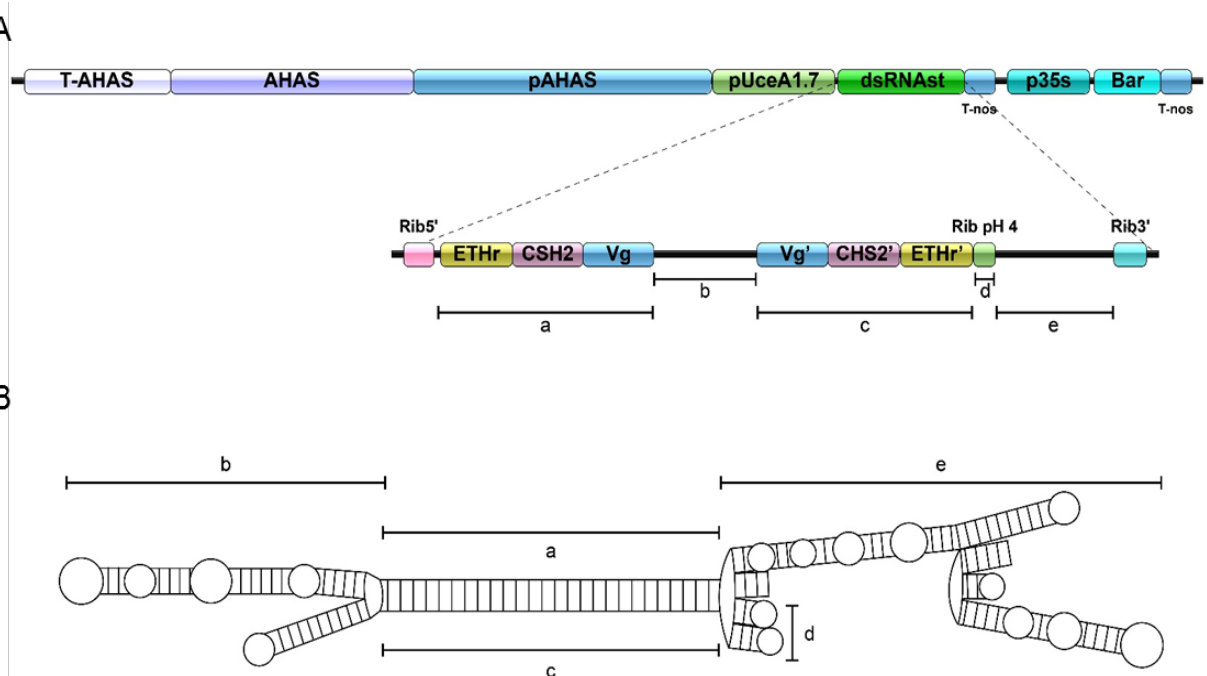
Figure 2. Map of the vector used for cotton transformation. ( A ) Schematic representation of the T-DNA construct for structured dsRNA (dsRNAst) expression in transgenic cotton. The binary vector pCambia3300 was used as the backbone. Imazapyr resistance is conferred to transformed plant cells by the Arabidopsis ahas mutant gene under the control of the ahas promoter ( pAHAS ), followed by the ahas terminator ( T-AHAS ). At the other end of the vector, the bar gene is under the control of the pCAMV35S promoter and the t - Nos terminator. Expression of dsRNAst is controlled by the constitutive pUceA1.7 promoter and the t-Nos terminator. The transcribed region of the dsRNAst fragment is highlighted in the figure: at each end of the transcribed sequence are two ribozyme sequences, Rib5’ (from Selaguinella moellendorffii) and Rib3’ (from Vitis vin í fera ), flanking the 5 (cid:48) and 3 (cid:48) ends of the dsRNA sequences, respectively. The sense (a) and antisense (c) sequence regions contain the target sequences, which in tandem contain fragments of sense and antisense cDNA sequences of A. grandis genes: ETHr: ecdysis triggering hormone receptor. CHS2: chitin synthase 2. Vg: vitellogenin. The regions encoding incompatibility handles are illustrated in the loop fragment (b) and in the terminal region (e). The (d) site encodes a ribozyme that self-cleaves at acidic pH < 5.0. ( B ) Predicted structure of the mature dsRNAst. Regions indicated by lowercase letters follow those regions described in Figure 2A.